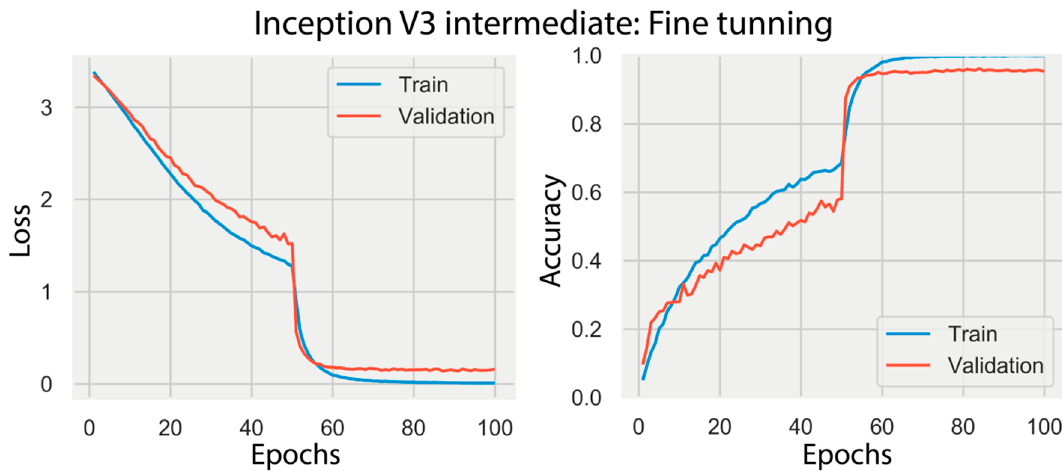
Figure 6. Train and validation loss and accuracy for the Inception V3 intermediate in the fine tuning mode trained on the AID dataset using SGD (1e-3) momentum 0.9. Remote Sens. 2019 , 11 , x FOR PEER REVIEW